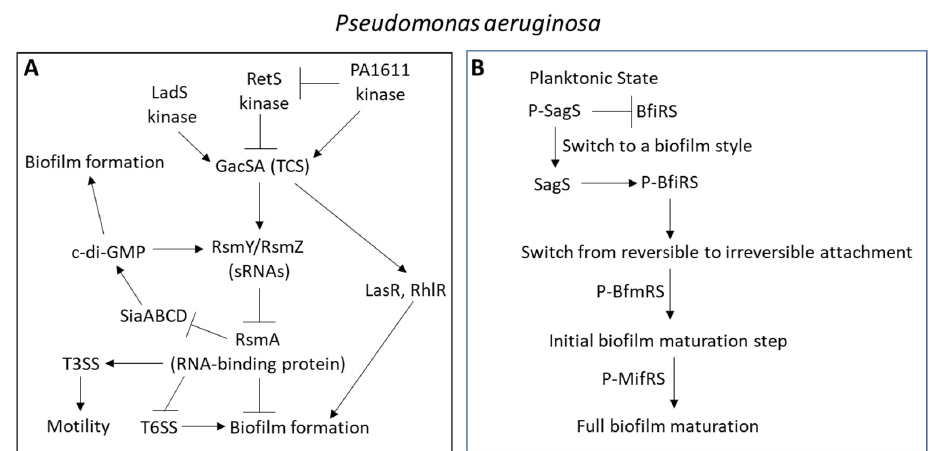
Figure 12. ( A ). Regulation of RsmY/RsmZ small RNAs by the GacSA TCS and c-di-GMP in Pseudomonas aeruginosa and the impact on biofilm formation . RsmY and RsmZ are small regulatory RNAs involved in the regulation of biofilm formation. Their expression is regulated by the TCS GacSA, whose activity is, in turn, regulated by the LadS, RetS, and P1611 kinases. RsmY and